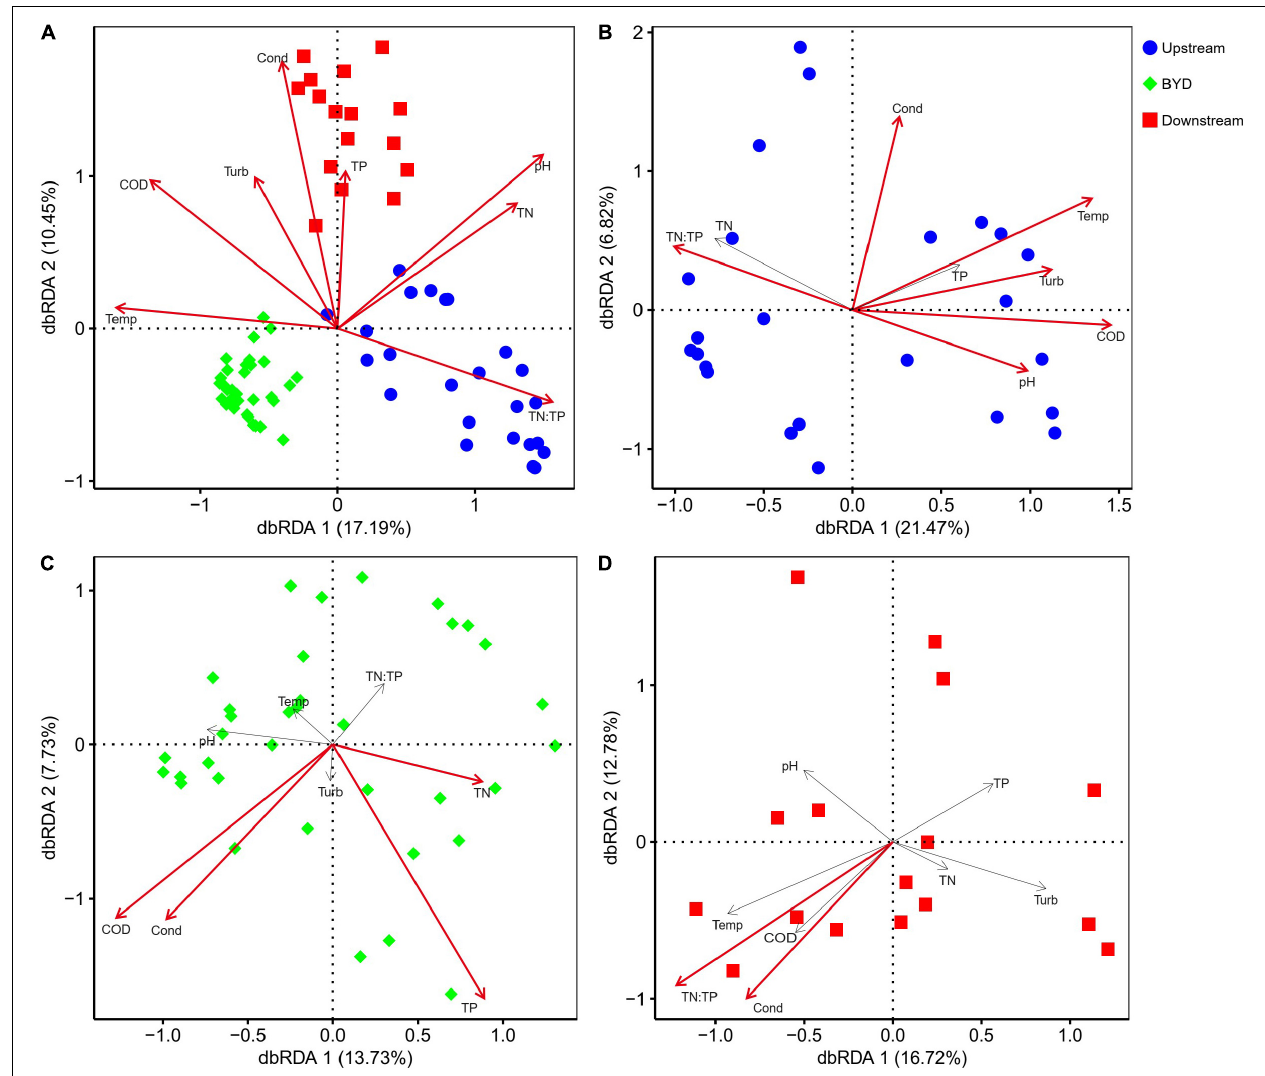
FIGURE 3 | Distance-based redundancy analyses (db-RDA) reveal the relationships between environmental variables (arrows) and microeukaryotic communities (points) in (A) the all three areas, (B) upstream, (C) BYD, and (D) downstream. Significant variables ( P < 0.05 by envfit function) are shown in red.